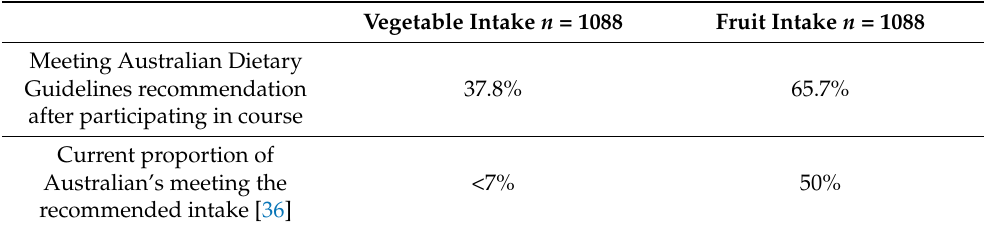
Table 7. Participants meeting recommended fruit and vegetables intake since doing the